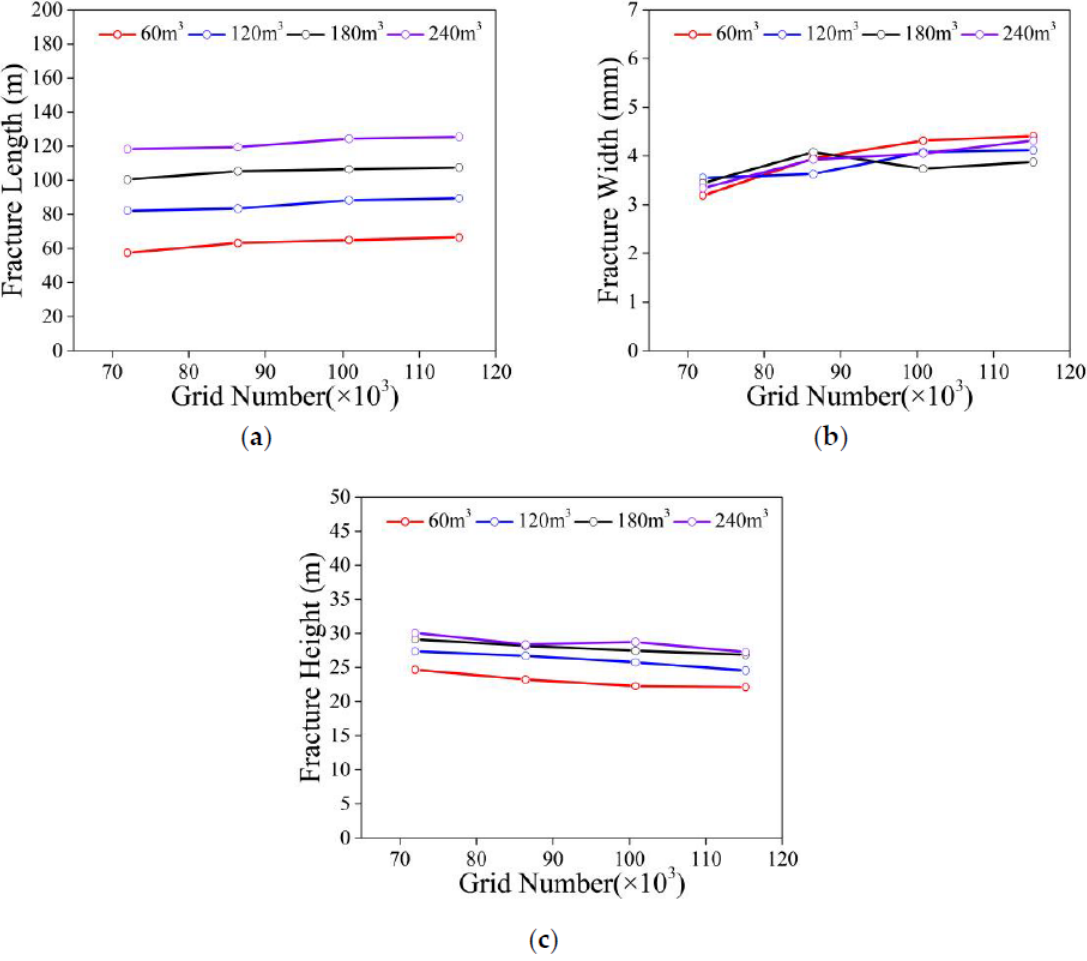
Figure 8. Results of grid independence verification. The changes to HF parameters, ( a ) fracture length, ( b ) fracture width, and ( c ) fracture height, under different volumes of injected fluid, i.e., 60 m 3 , 120 m 3 , 180 m 3 , and 240 m 3.